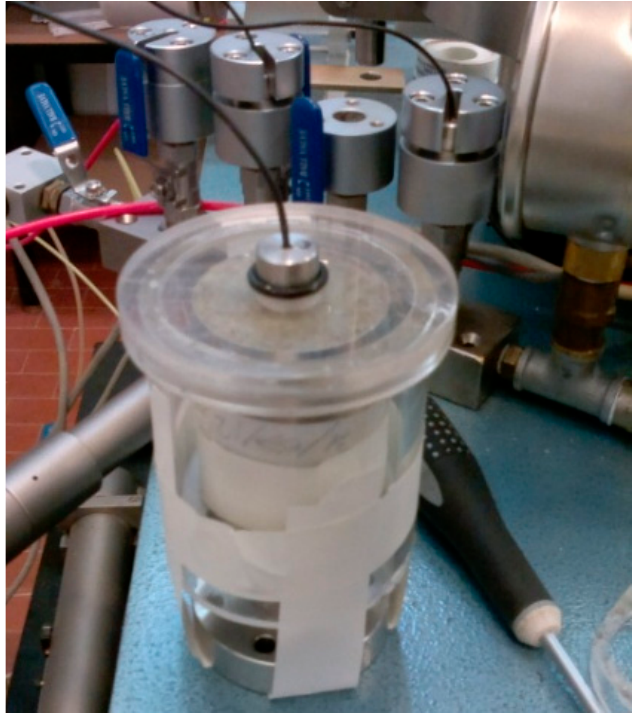
Figure 4. Example of high-capacity tensiometer